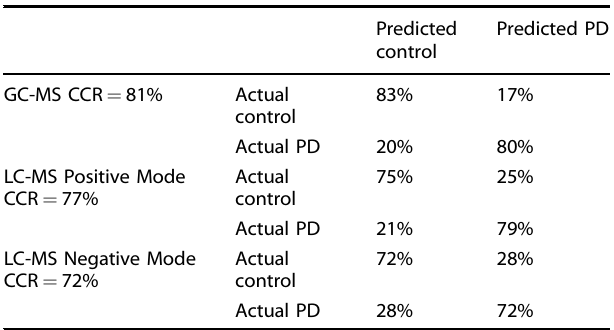
Table 1. Confusion matrices.